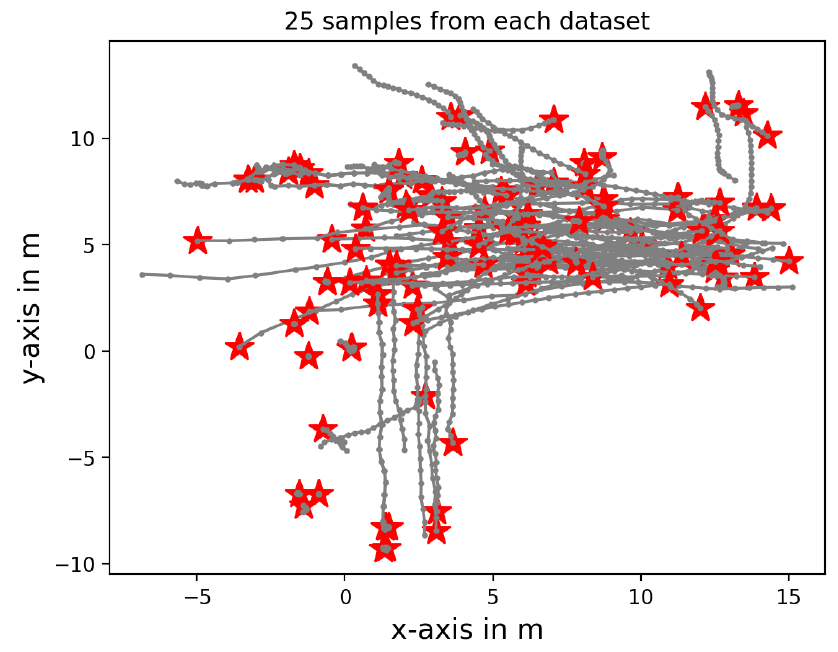
Figure 3. 25 randomly sampled trajectories from each dataset. (cid:63) represents the trajectory start- ing